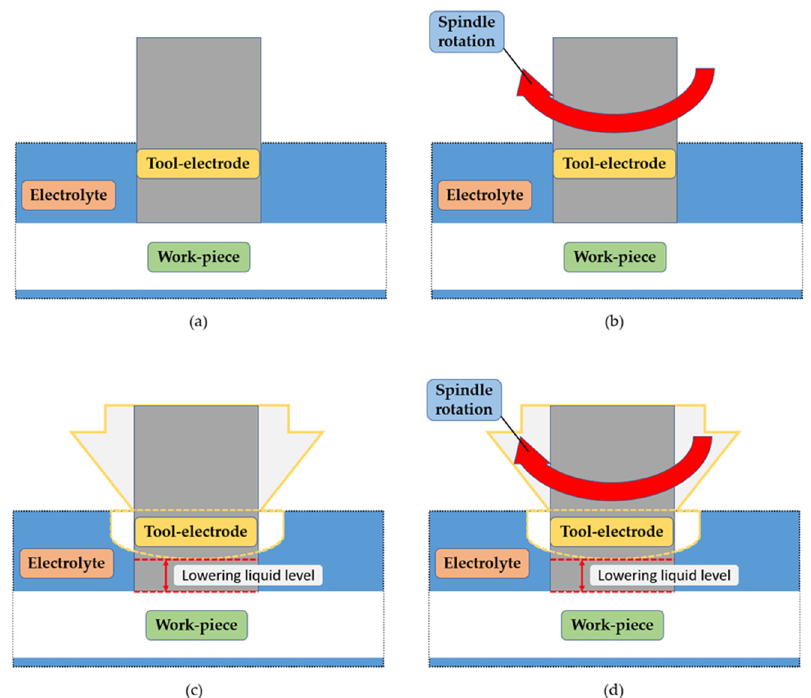
Figure 4. Machining method schematic views: ( a ) fixed electrode machining; ( b ) electrode rotation machining; ( c ) jet assisted machining; and ( d ) combinational assisted machining.